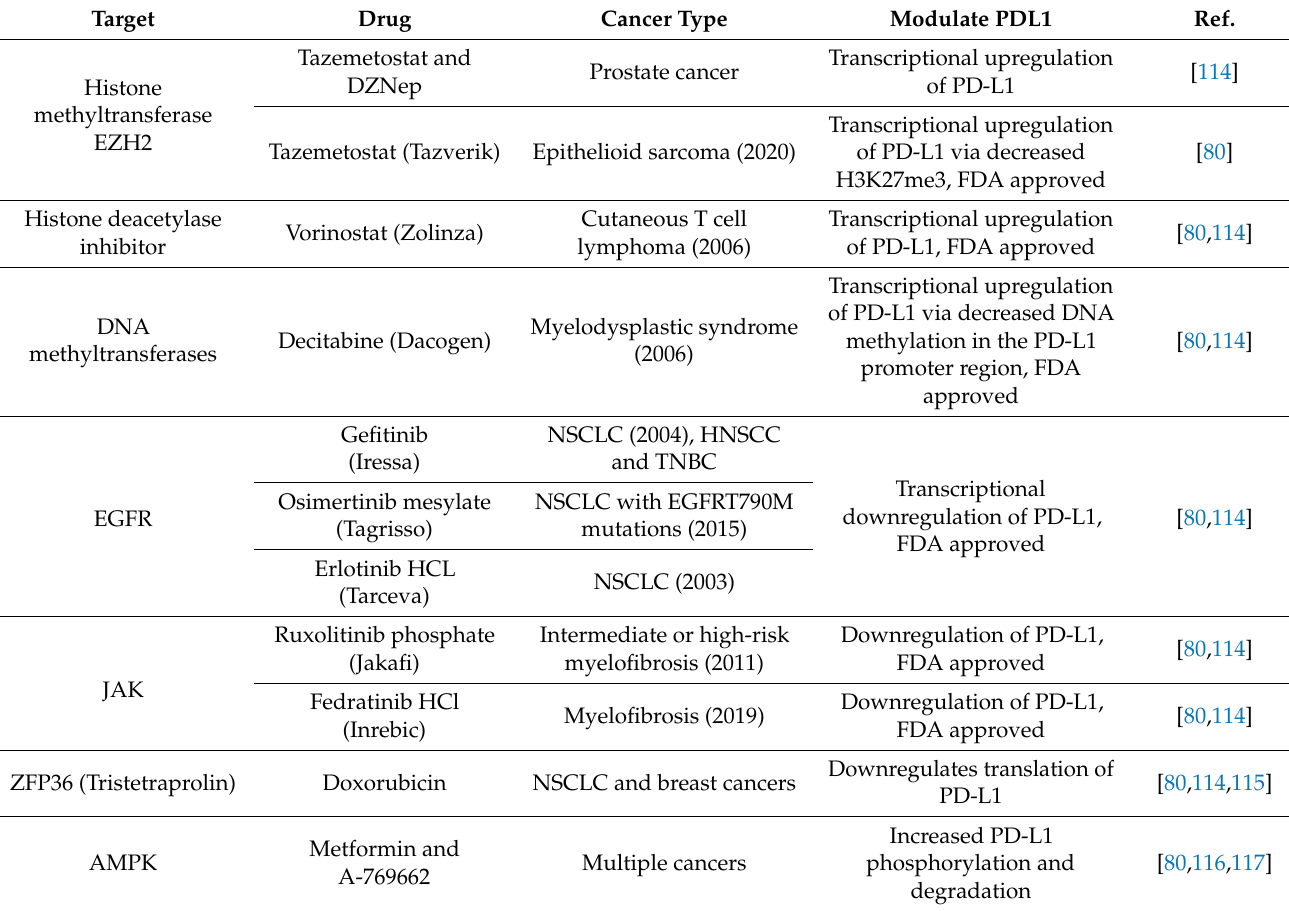
Table 3. Small drugs with checkpoint inhibition capacity in cancer